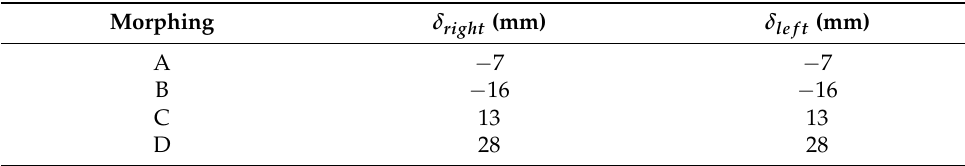
Table 4. Actual deflections of the wing during bending due to arbitrary morphing A to D.